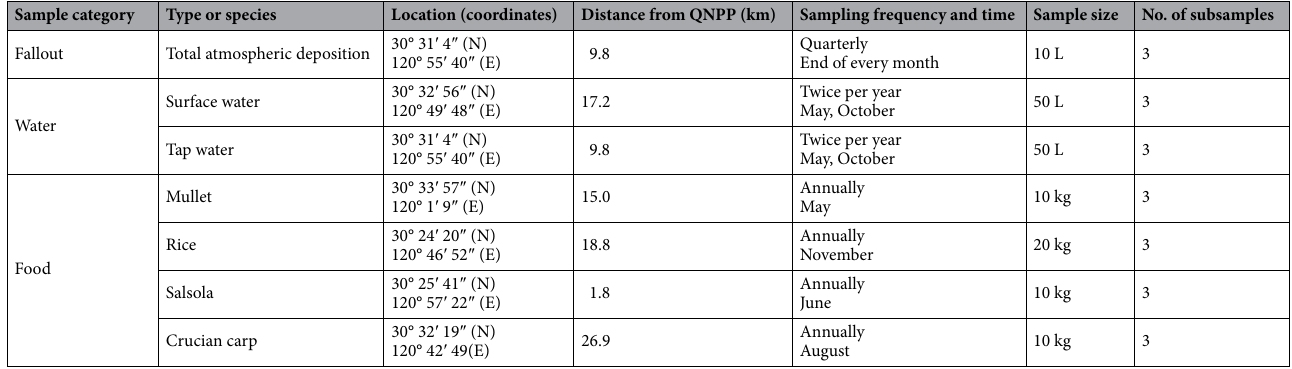
Table 1. Samples collected from QNPP in this work during